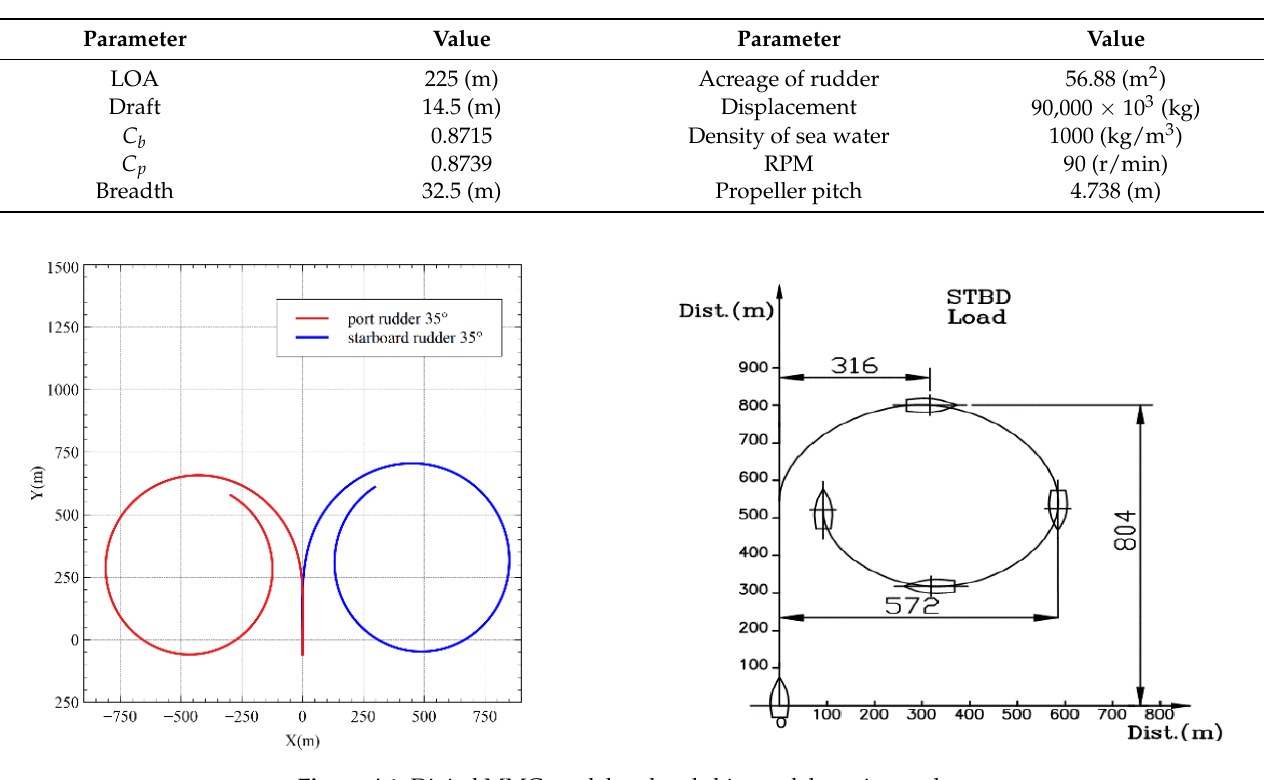
Table A1. HUAYANG DREAM ’ s parameters.